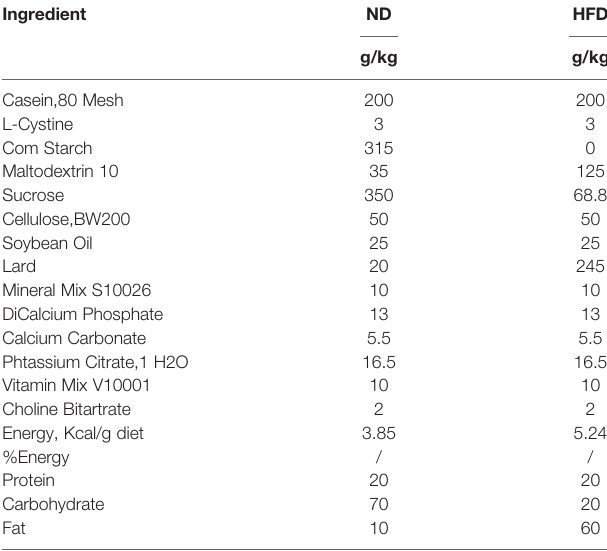
TABLE 1 | Dietary composition and energy content of the experimental diets a